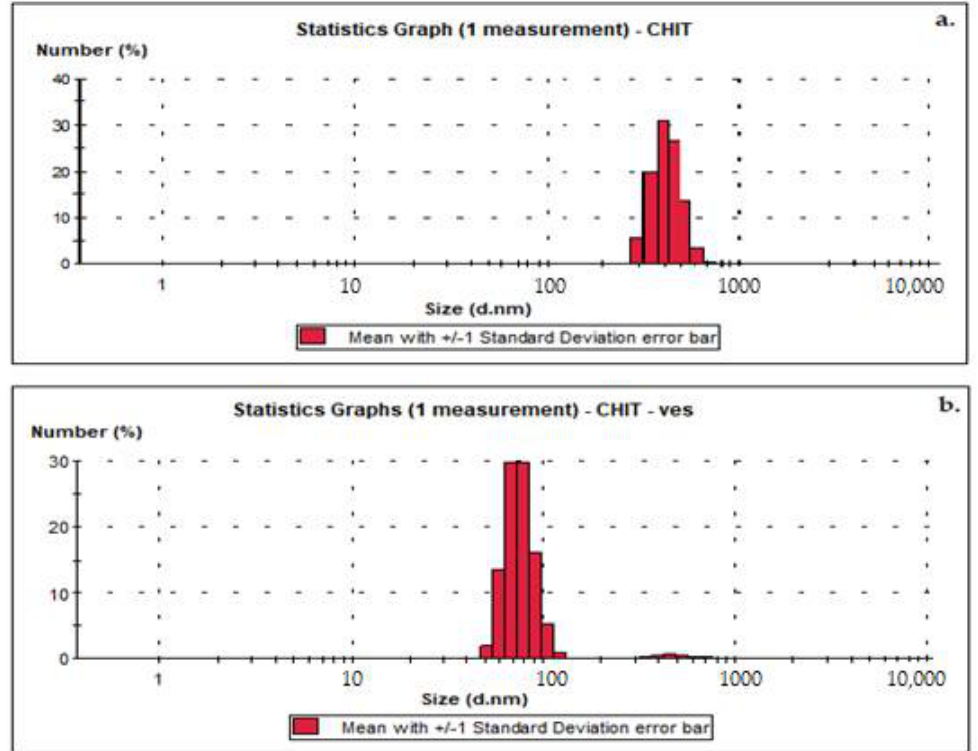
Figure 2. Size distribution ofchitosan solution ( a ) andchitosan vesicles ( b ). The average value of the zeta potential of 13.2 mV of chitosan solution indicates a low level of stability, as the suspension reaches the agglomeration threshold (Figure3a). The obtained chitosan vesicles proved to have a mean zeta potential of 32.4 mV, thus suggesting a moderate stability of the colloidal suspension (Figure3b).